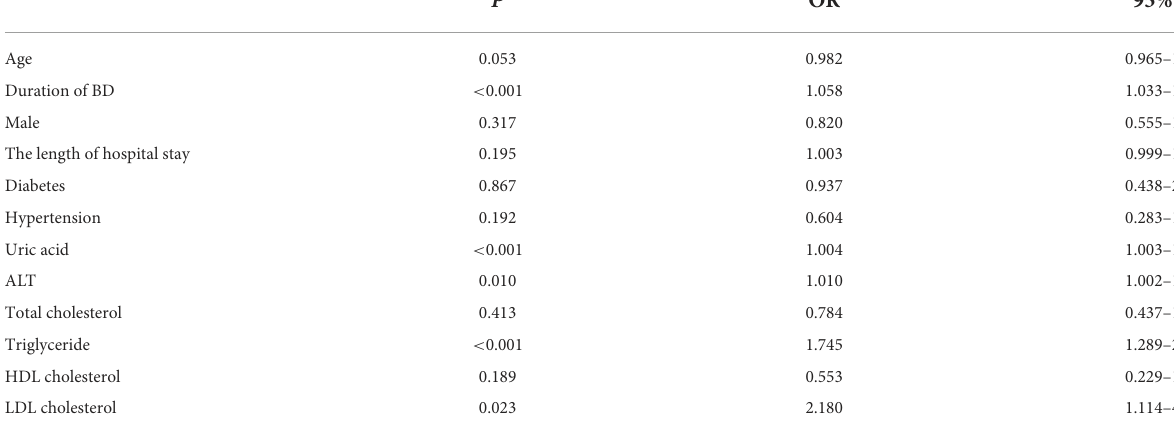
TABLE 2 Associated factors for obesity in patients with